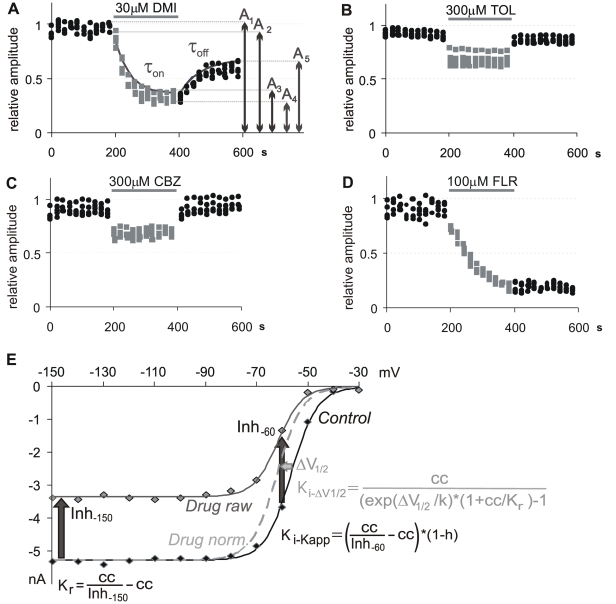
Calculation of parameters and examples for the different types of inhibition caused by SCIs.
A)–D) Peak amplitudes of evoked currents (5 Hz trains of 5 depolarizations from −90 to −10 mV) are plotted against time. Black dots: Control. Grey dots: Drug perfusion. A) ‘Type 1’ inhibition (high potency, slow kinetics, partial reversibility, use-dependence). Calculation of properties of inhibition is illustrated. Inhibition: Inh
  =  (A1−A3)/A1; IC50
  =  (1−Inh) * cc/Inh, where “cc” is the concentration; Reversibility: 
Rev
  =  A5/A1; Use-dependence: UD
  =  (A3/A4)/(A1/A2); τon and τoff are determined by monoexponential fitting of peak amplitudes of the first evoked current in each train. B) Use-dependent ‘Type 2’ inhibition (low potency, fast kinetics, good reversibility, use-dependence). C) Non-use-dependent ‘Type 2’ inhibition (low potency, fast kinetics, good reversibility, no use-dependence). D) ‘Type 3’ inhibition (high potency, very slow kinetics, apparently irreversible, no use-dependence). E) Calculation of Kr and Ki values from steady-state availability curves.